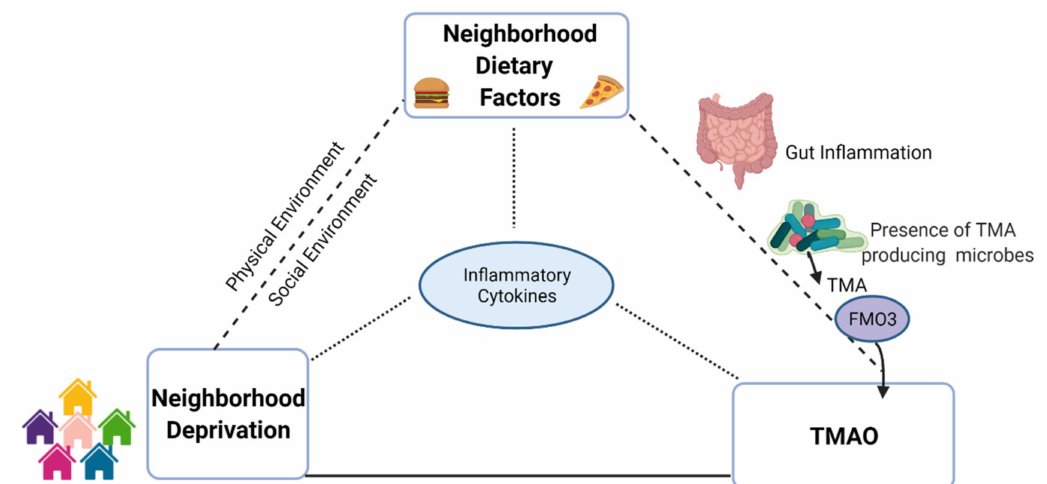
Figure 1. Graphical depiction of hypothesis for neighborhood-diet-inflammatory connection to explain hypothesized differences in trimethylamine-N-oxide levels based on neighborhood deprivation. NDI: neighborhood deprivation index; TMA: trimethylamine; FMO3: flavin monooxygenase isoform 3; TMAO: